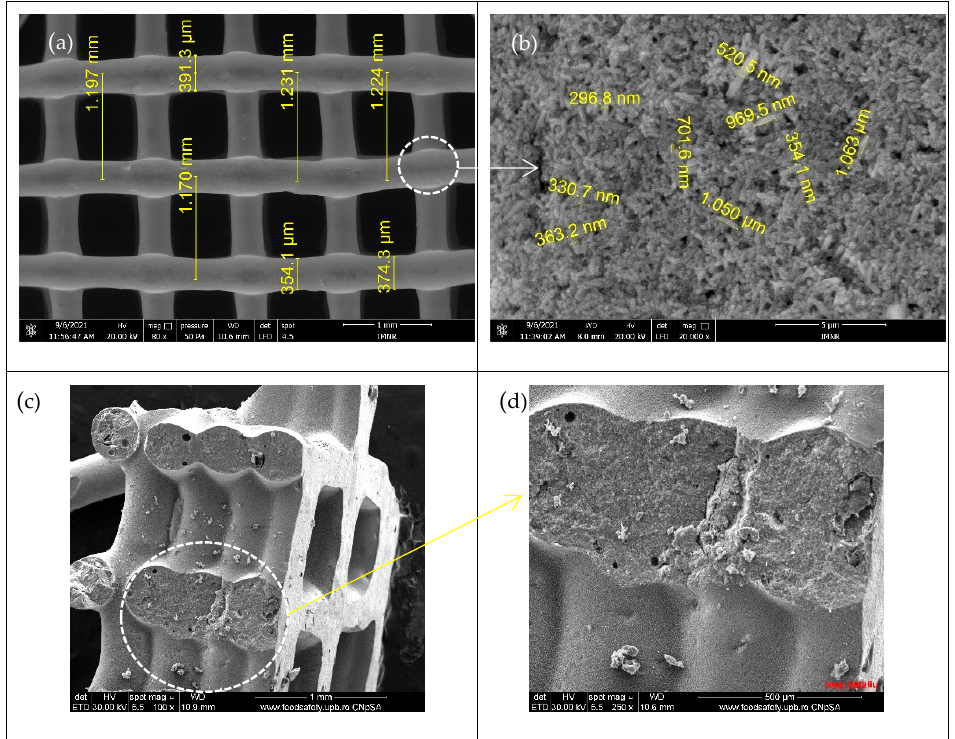
Figure 3. SEM micrographs of ZnO-CNT-based 3D support structure before impregnation: ( a ) 3D structure; ( b ) detail from (3a) strand morphology; cross-section images: ( c ) 100× magnification; ( d ) 250× magnification.